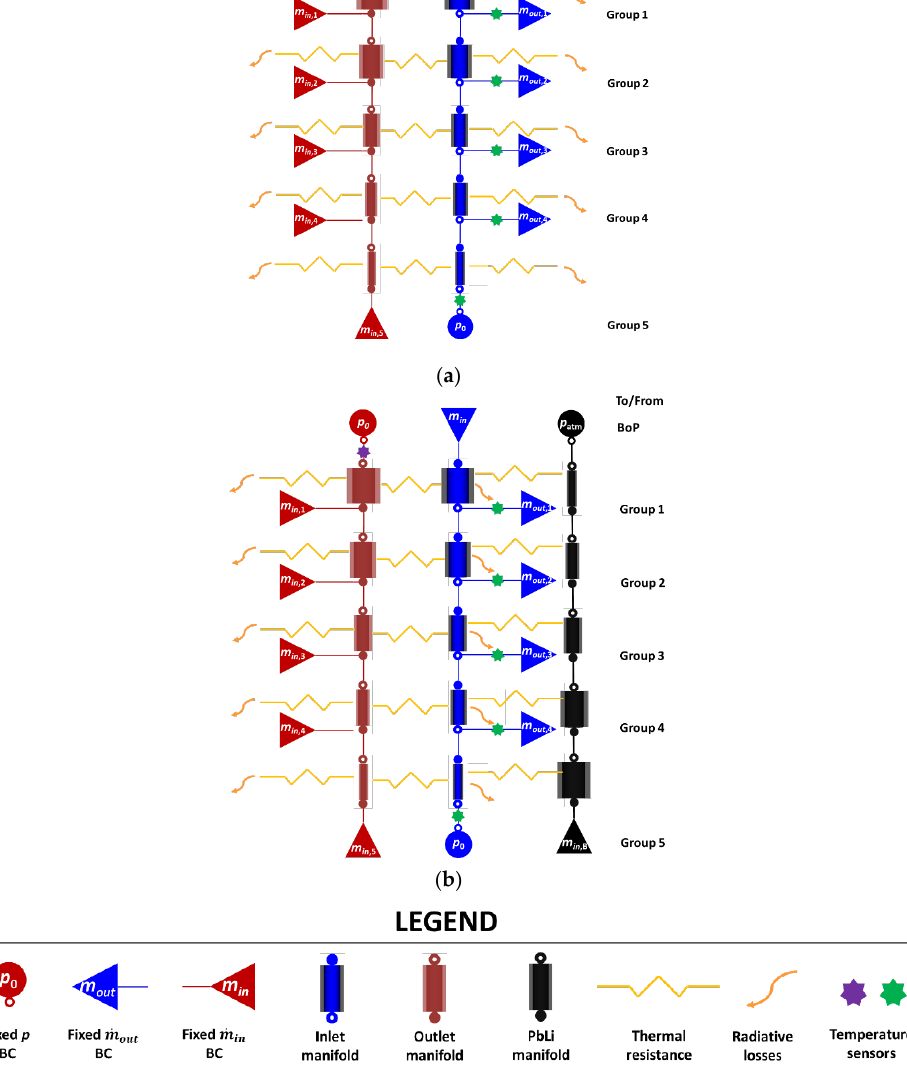
Figure 6. Sketch of the 1D GEneral Tokamak THErmal-hydraulic Model (GETTHEM) models: ( a ) first wall (FW) and breeding zone (BZ) manifolds model neglecting heat transfer with PbLi manifolds; ( b ) BZ manifolds model including heat transfer with PbLi manifolds. The thermal resistances before the radiative losses represent the solid material between the manifolds and the vacuum vessel (VV)-facing walls. The different boundary conditions (BCs) refer to different groups of channels, whose naming convention is reported. Different dimensions of the manifold channels are used to represent the variation of the cross section.